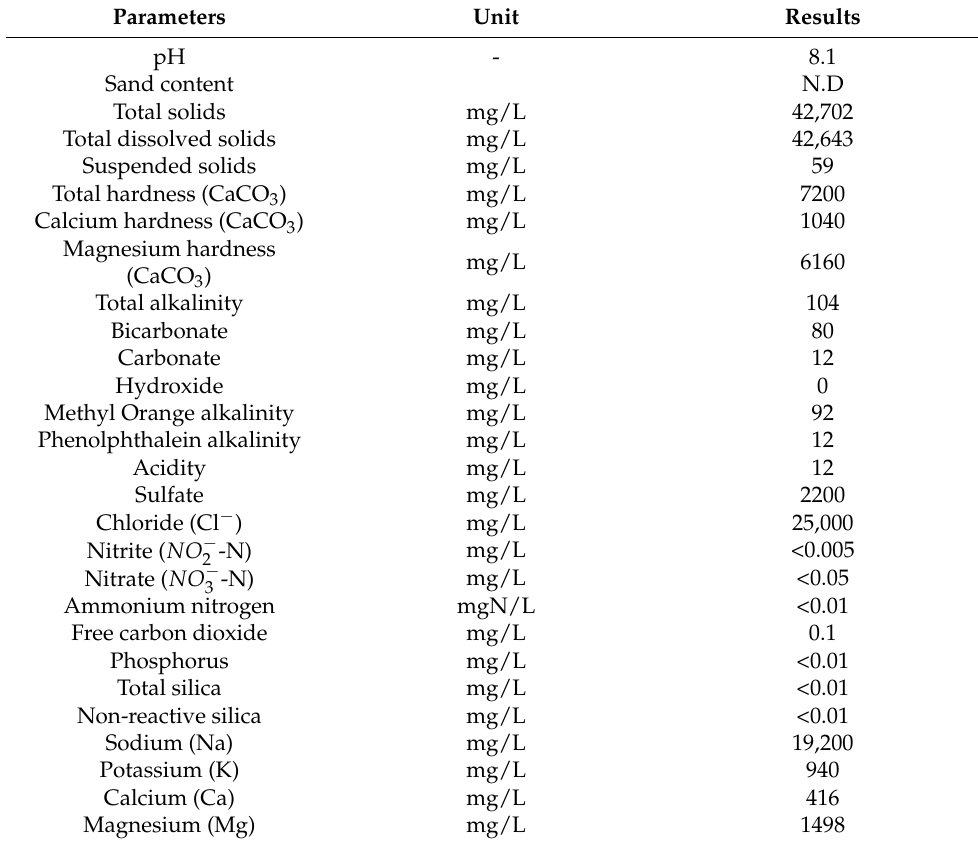
Table 5. Physico-chemical analysis of seawater.